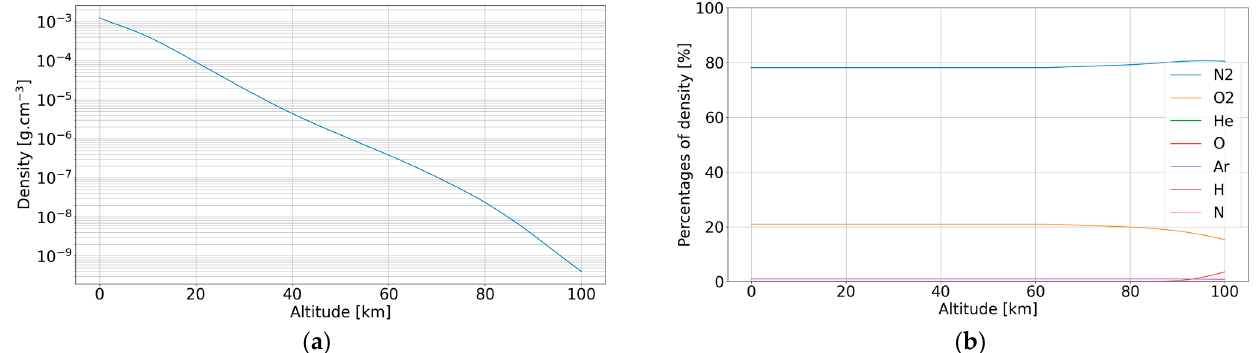
Figure 5. Evolution of the atmospheric composition and density based on MSISE2000 for Paris, France on 21 June 2022: ( a ) Evolution of the atmosphere density as a function of altitude; ( b ) Evolution of the constitution of the atmosphere as a function of altitude.